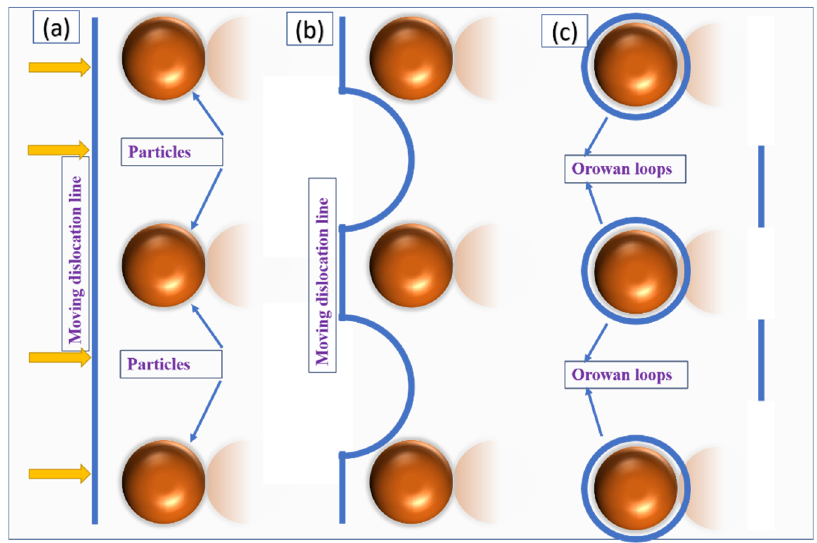
Figure 13. Orowan mechanism of moving the location line from zone A to C and Orowan loop for- mation.